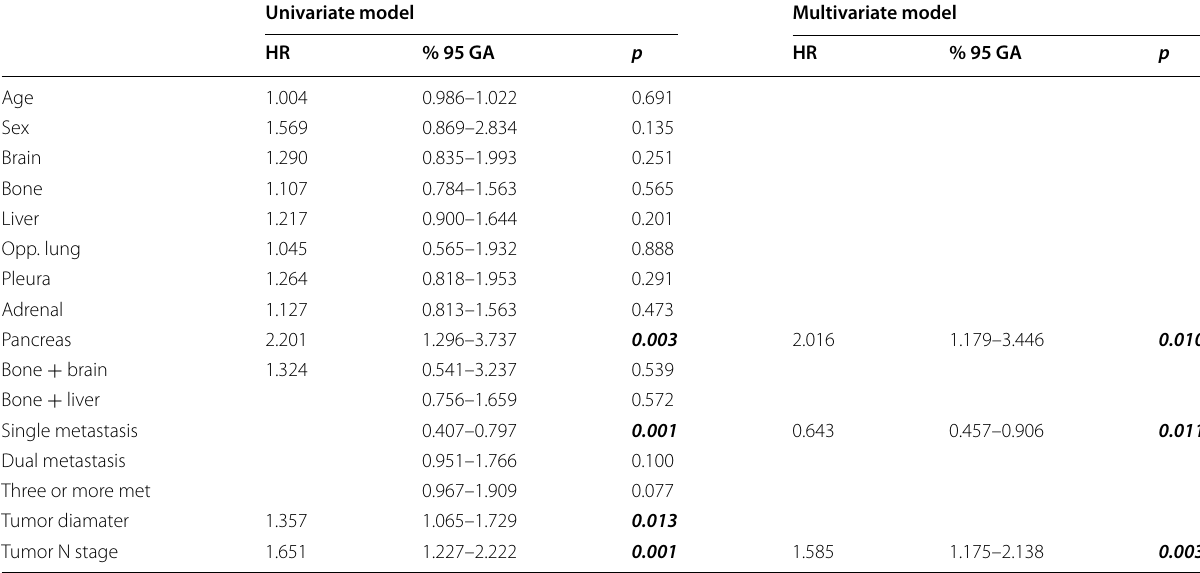
Table 3 Tumor characteristics in the univariate and multivariate models